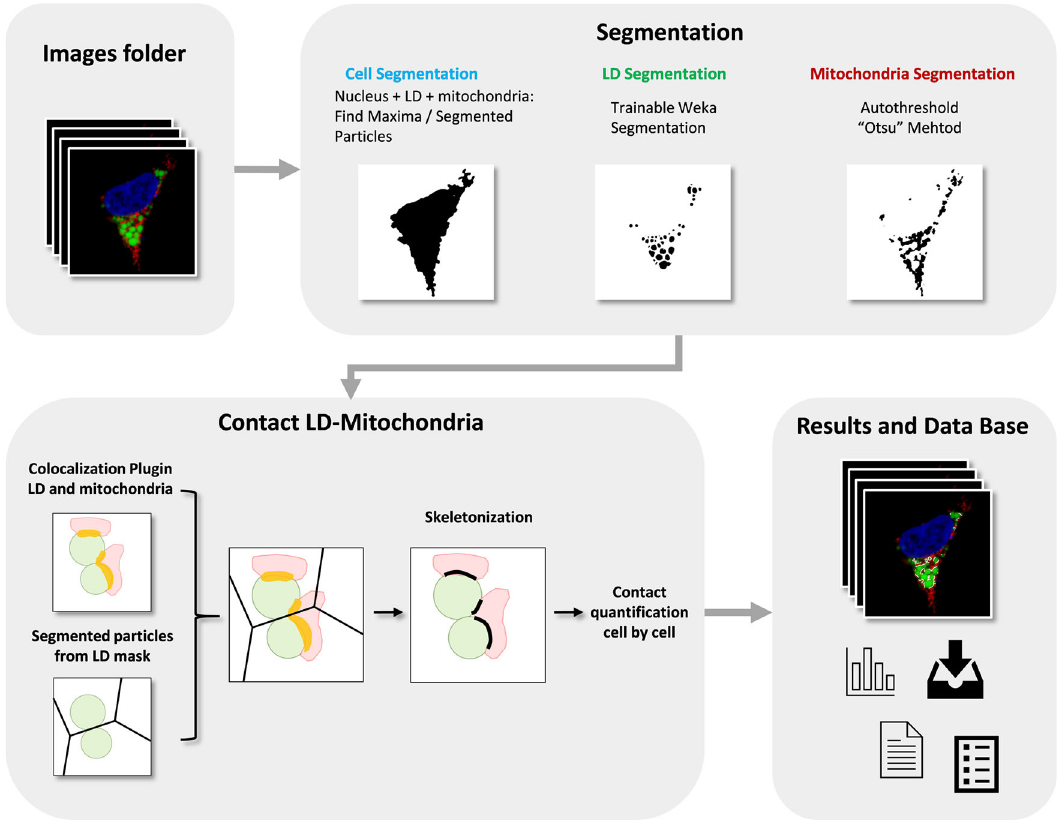
Figure 1. Flowchart of ContactJ Macro that automatically segments and measures the LD-mitochondria contacts cell by cell by combining standard and machine learning segmentation processes and the novel useofcolocalizationtogetherwithskeletonizationmethodsfromalargenumberoffluorescenceimages. LD, Mitochondria,ColocalizationAreaandfinalContactSitearerepresentedingreen, red,yellowand